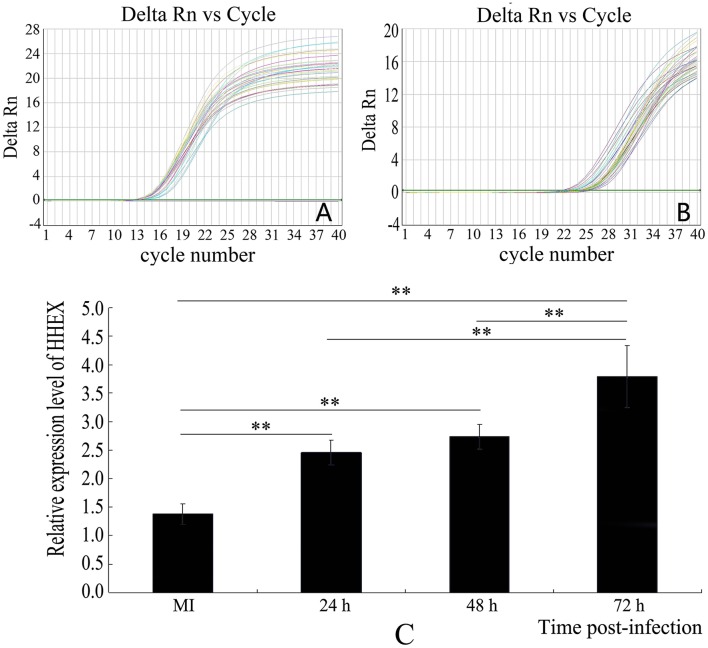
Expression of HHEX was assayed by real-time PCR. (A) β-actin amplification curve; (B) HHEX amplification curve; (C) Relative mRNA expression of HHEX. The results showed that HCMV promotes the expression of HHEX (n = 4, **P < 0.01).